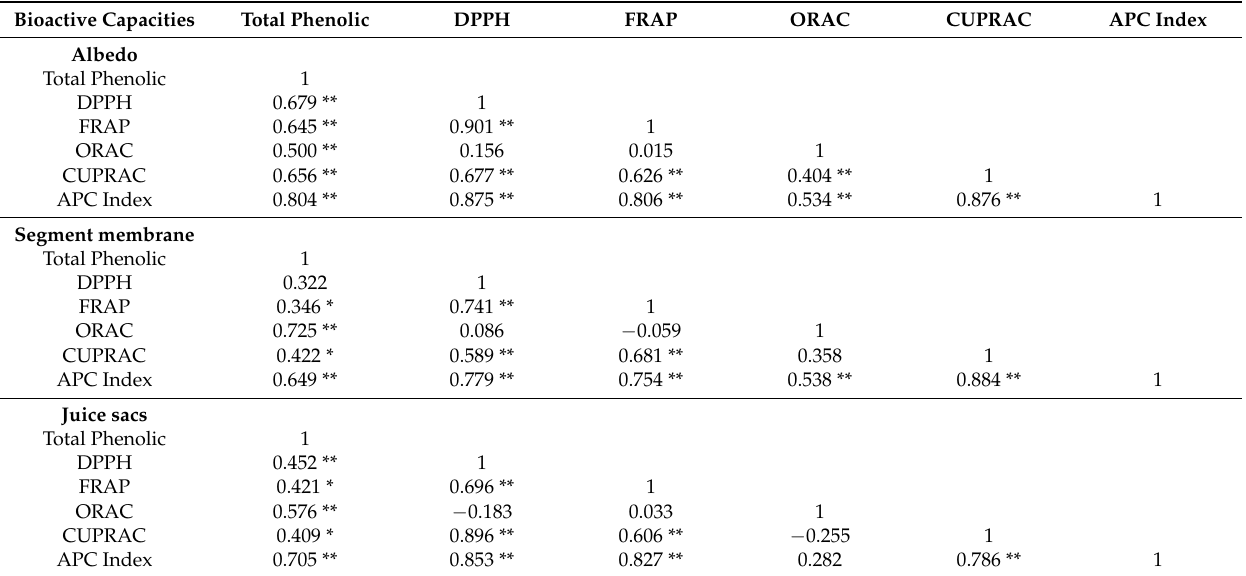
Table 9. Pearson’s correlation coefficients among total phenolics, antioxidant values in albedo, segment membrane and juice